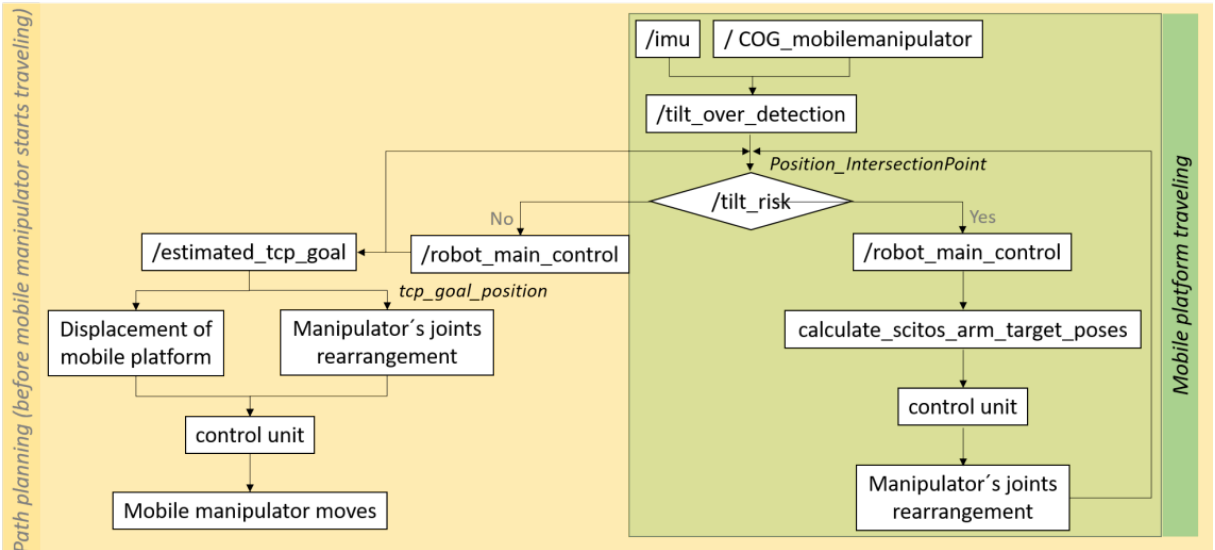
Figure 16. Control procedure for stabilization strategy.